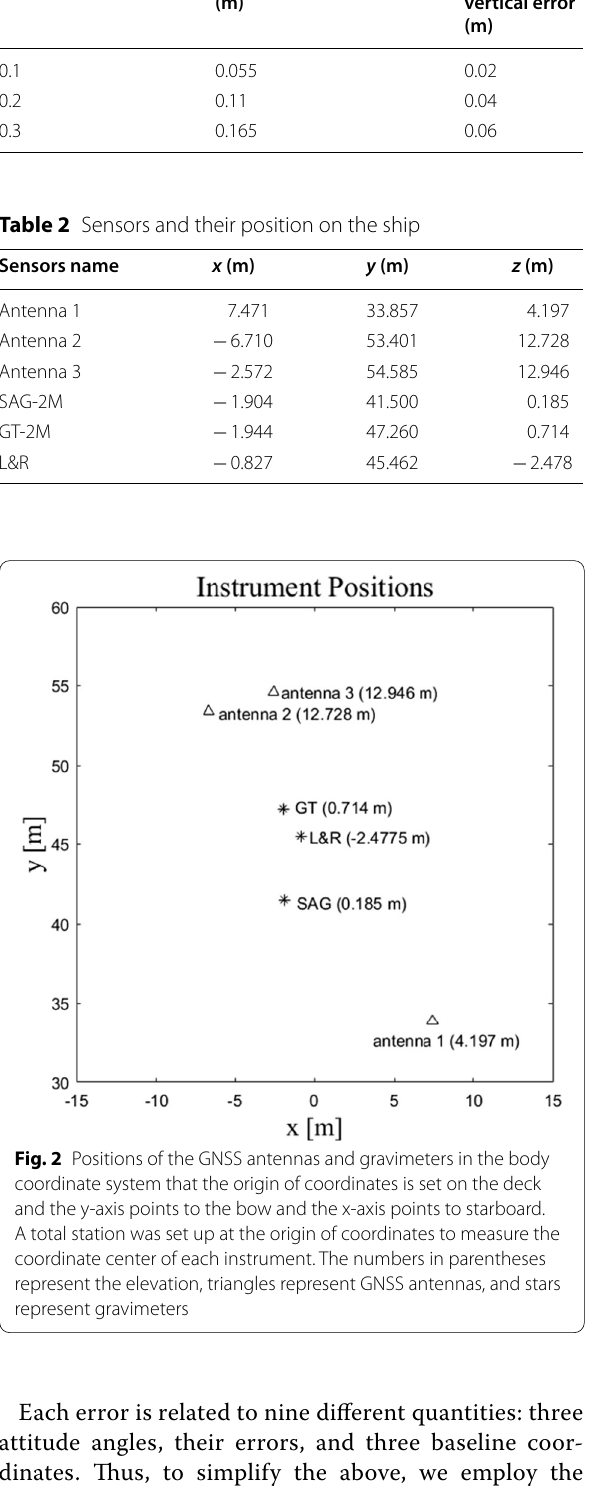
Table 1 Maximum eccentricity correction errors with different attitude angle errors Attitude angle error (°) Maximum horizontal error (m)